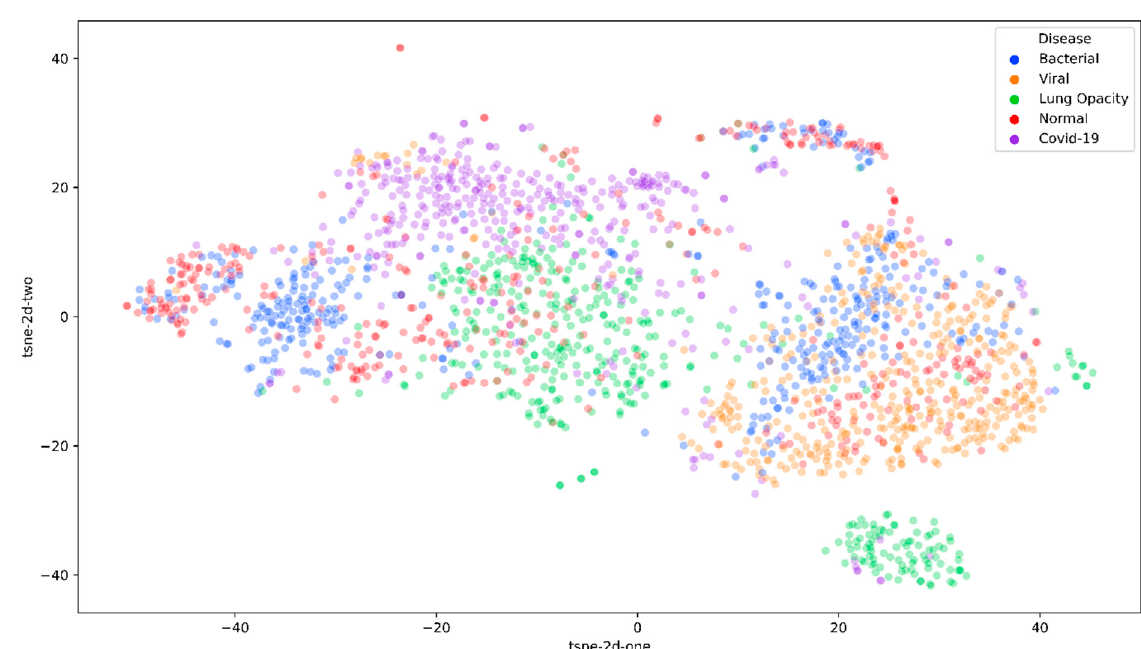
Figure 9. TSNE results. Figure 9. TSNE